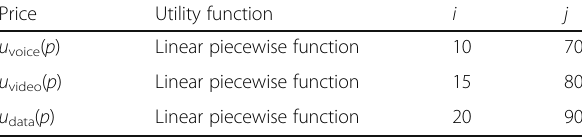
Table 5 Utility function for price and parameter settings